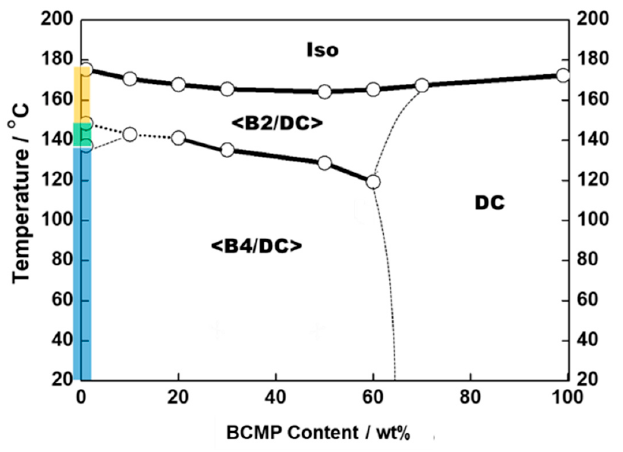
Figure 4. Phase diagram of various mixtures containing different fractions of BC molecule and BCMP.